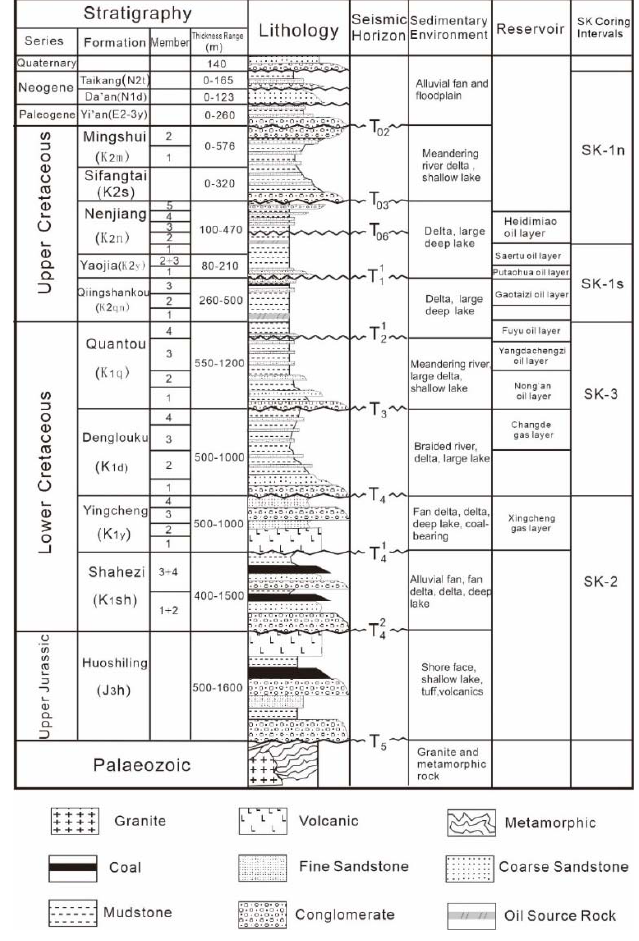
Figure 2. Stratigraphy in the Songliao Basin and coring strategy of the SK scientific drilling projects [1,2,6].